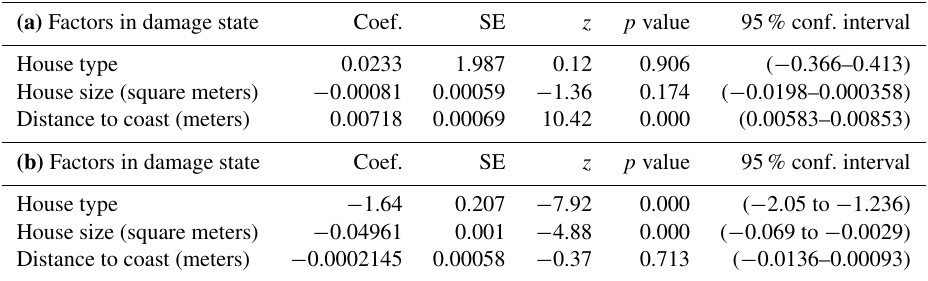
Figure 3. Spatial distribution of estimated hazards and damage states in study areas. Panels (a) and (b) show simulated maximum total water level and significant wave height, respectively; panels (c) and (d) show assessed damage state (none: green; minor: yellow; major: orange; destroyed: red) for residential buildings in Big Pine Key and Marathon, respectively. Table 2. Ordered logistic regression models that correlate damage state with vulnerability factors (a) for 846 assessed buildings in Big Pine Key (219 trailers and 627 single family); (b) for 811 buildings in Marathon (263 trailers and 548 single